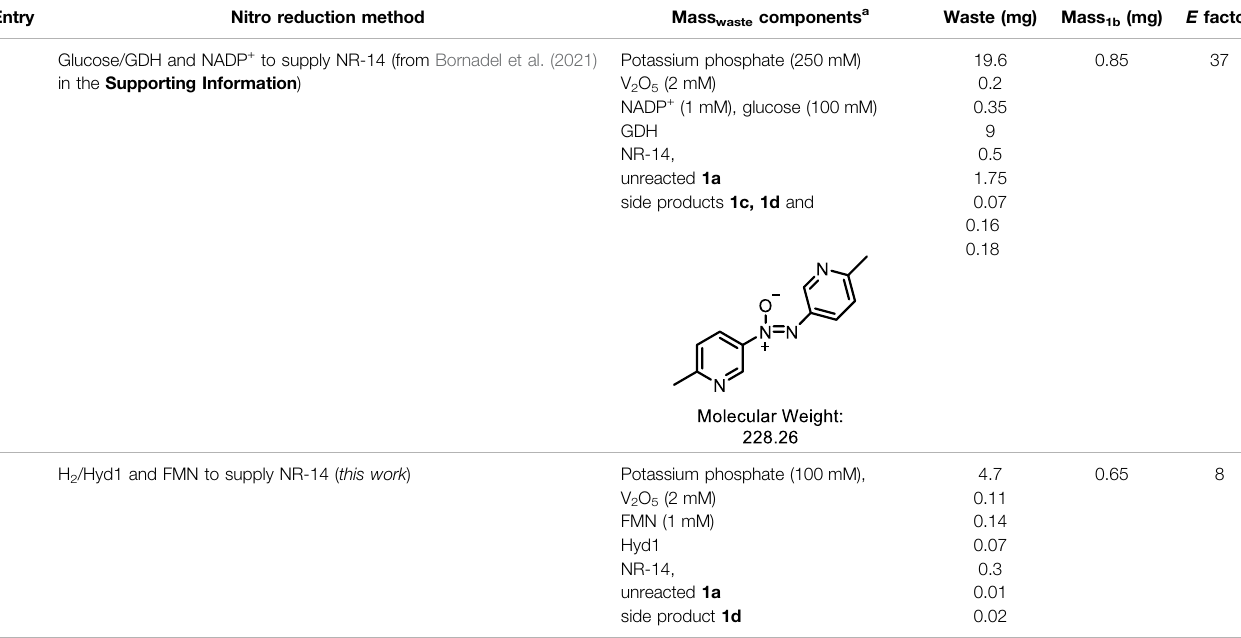
TABLE 3 | E factor comparison of the nitroreductase reactions using either glucose/GDH/NADP + or H 2 /Hyd1/FMN. Entry Nitro reduction method Glucose/GDH and NADP + to supply NR-14 (from Bornadel et al. (2021) in the Supporting Information